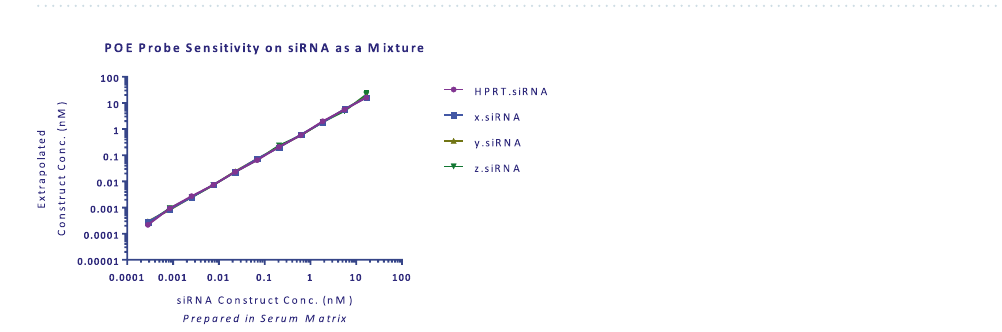
Table 2. Stability of HPRT.siRNA antisense strand assessed in Sprague-Dawley serum and liver homogenate with repeat freeze thaws and with storage at room temperature (4 hours) and deep freeze ( − 80 °C, ~2 weeks).